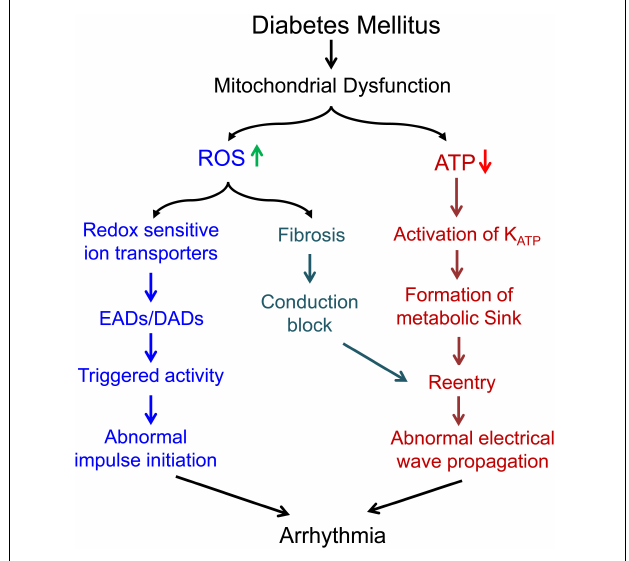
FIGURE 2 | Summary of the potential mechanisms underlying the proarrhythmic role of mitochondrial dysfunction in diabetes mellitus.